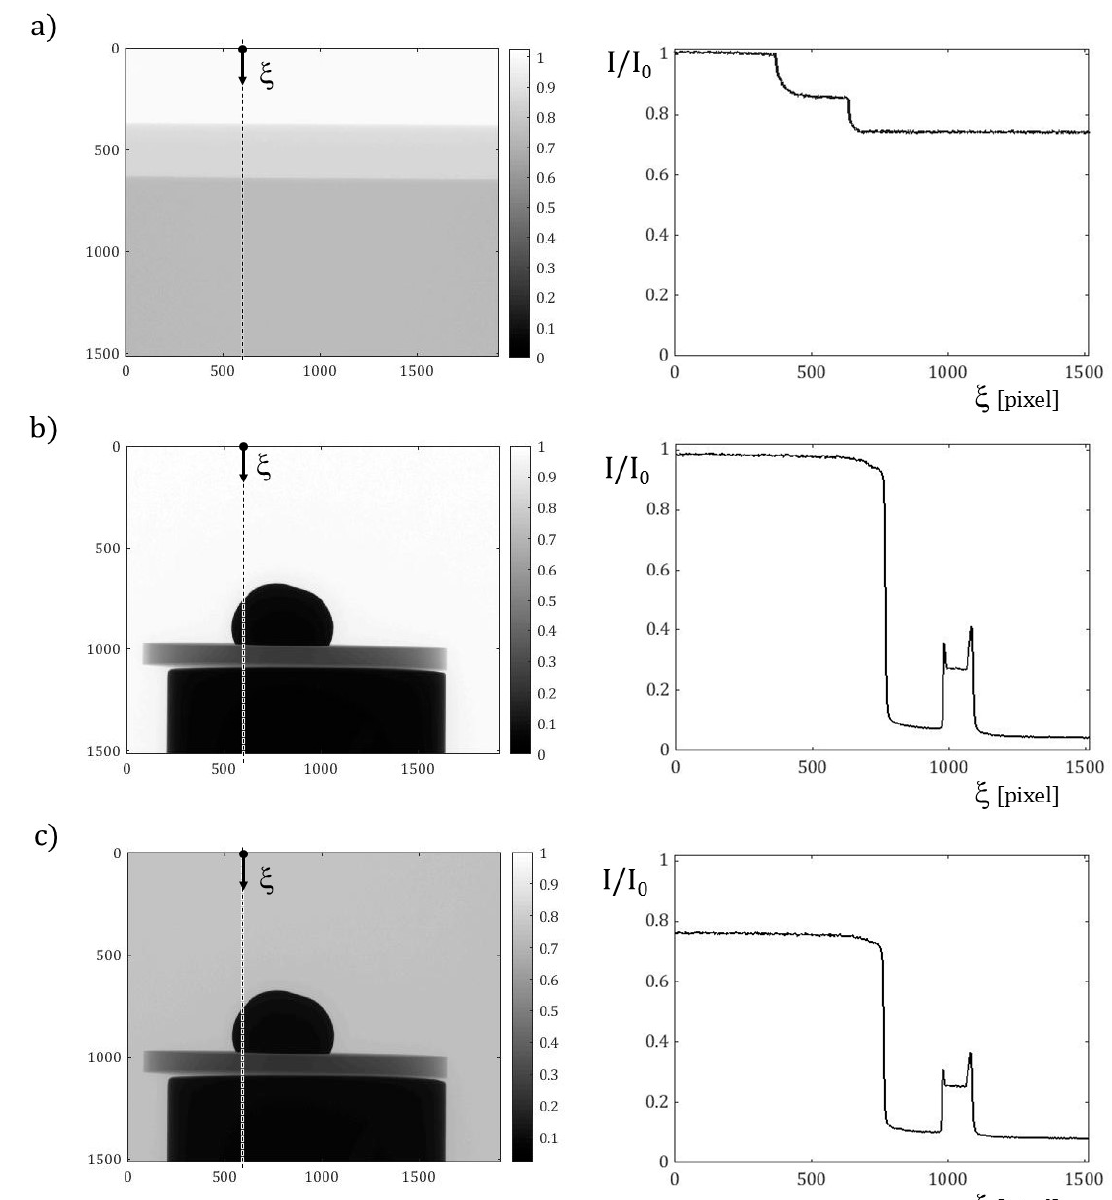
Figure 9. X-ray radiographs, acquired with the same beam parameters, in the left column, and relevant transmission I/I 0 evaluated along the vertical section marked by the dashed line and run by the coordinate ξ , in the right column. Content per row: ( a ) from above to below, flat-field I 0 , 2 mm quartz and 4 mm quartz attenuated image; ( b ) Ag solid droplet on a sapphire substrate, positioned on a further support; ( c ) the same sample and angular projection, placed inside a 2 mm thick quartz tube.